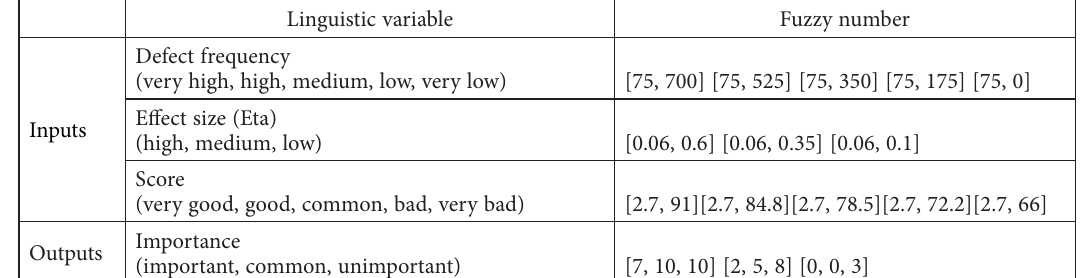
Table 5. Fuzzy linguistic